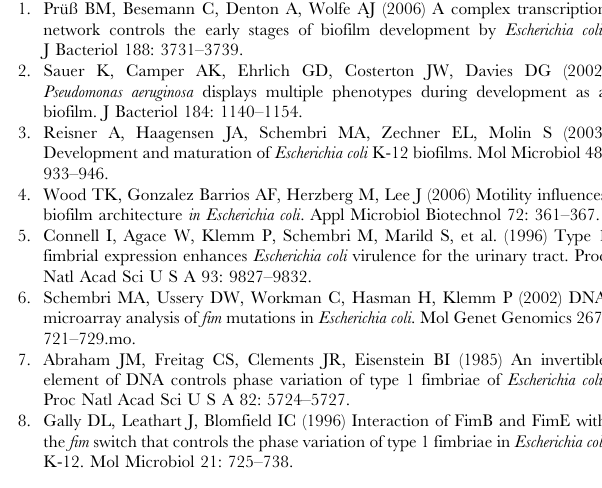
Table S6 E. coli DLP12 and CP4-57 prophage genes that are differentially regulated (P , 0.05) in BW25113 biofilms upon deleting hha in LB glu after 15 h and in LB glu after 24 h. Table S7 E. coli genes induced and repressed more than 4 fold (P , 0.05) in exponentially-growing suspension cells (turbidity at 600 nm of 1) upon hha overexpression in E. coli K12